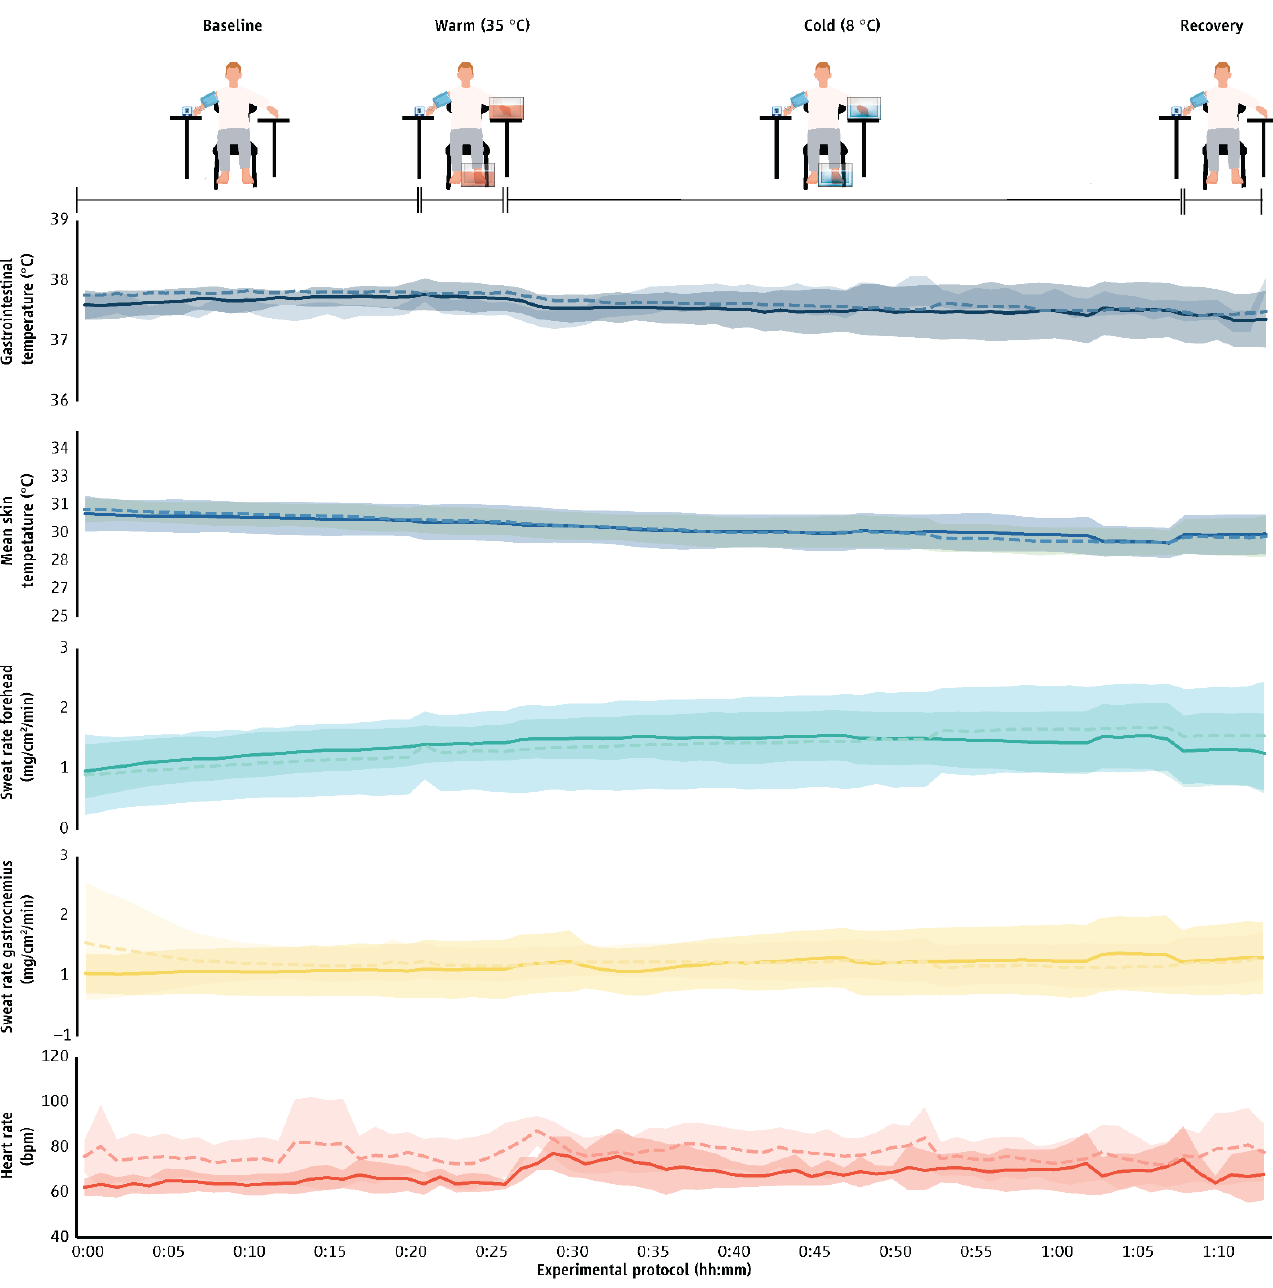
Figure A3. Physiological parameters (mean ± SD) during exposure to the cool environment (16 ± 1 °C) in the two groups. The first 20 min (00:00 to 00:20) indicate data collected during the baseline phase, the next five min (00:20 to 00:25) indicate responses during the warm-water immersion, the next 40 min (00:30 to 00:70) indicate responses during the cold-water immersion, and the final five min (00:70 to 00:75) show responses during the recovery phase. Continuous yellow lines indicate results for men participants and with dashed yellow lines present results for the women individuals.